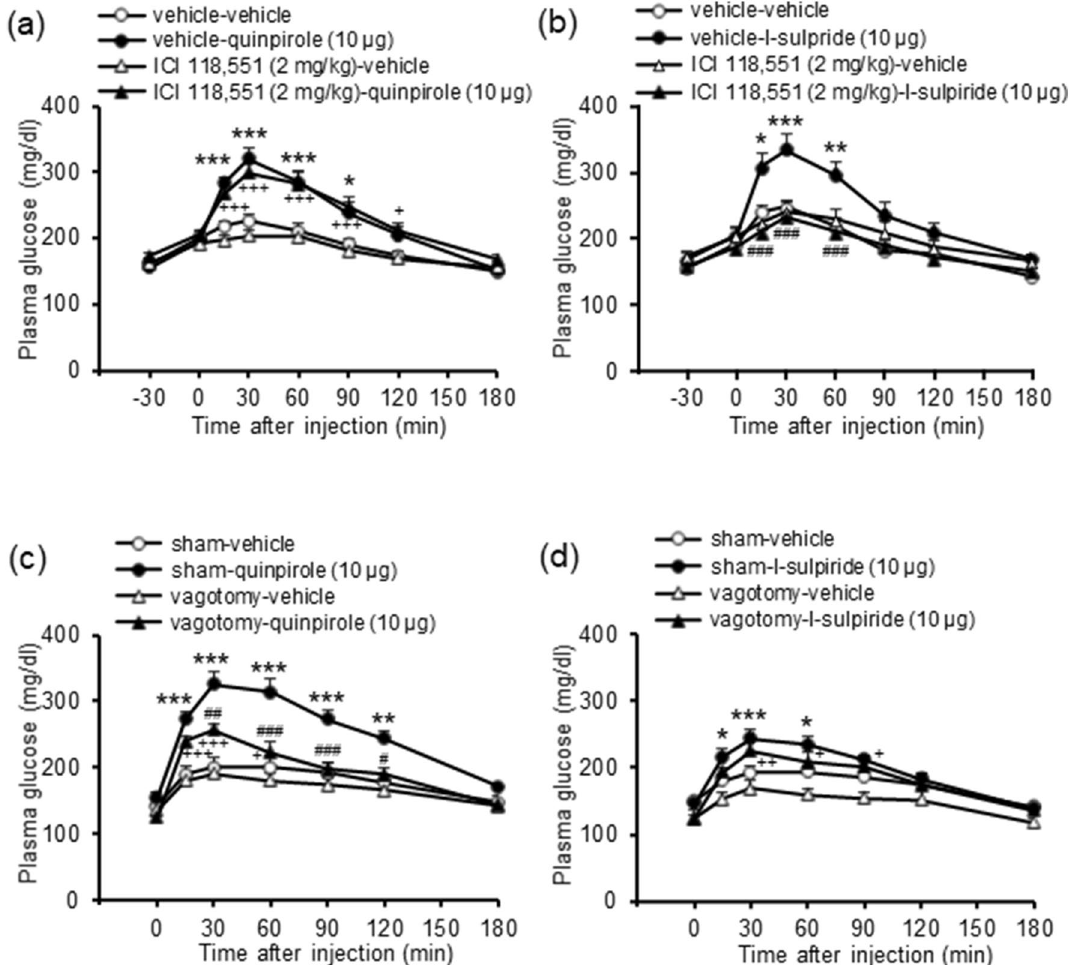
Figure 5. Role of sympathetic and parasympathetic nerves in hyperglycemia induced by the dopamine D 2 receptor agonist and antagonist. ( a , b ) Effect of the β 2 adrenoceptor antagonist ICI 118,551 on hyperglycemia induced by quinpirole or l-sulpiride. ICI 118,551 (2 mg/kg, i.p.) was administered 30 min before injection of quinpirole (10 μg, i.c.v.; a ) or l-sulpiride (10 μg, i.c.v.; b ). Each point represents the mean ± S.E.M. of 8–15 mice. * P < 0.05, ** P < 0.01, *** P < 0.001 vs. vehicle-vehicle group. + P < 0.05, +++ P < 0.001 vs. ICI 118,551-vehicle group. ### P < 0.001 vs. vehicle-l-sulpiride group. ( c , d ) Effect of hepatic vagotomy on hyperglycemia induced by quinpirole (10 μg, i.c.v.; c ) and l-sulpiride (10 μg, i.c.v.; d ). Hepatic vagotomy was conducted at least 1 week before drug injections. Each point represents the mean ± S.E.M. of 7–12 mice. * P < 0.05, ** P < 0.01, *** P < 0.001 vs. sham-vehicle group. + P < 0.05, ++ P < 0.01, +++ P < 0.001 vs. vagotomy-vehicle group. # P < 0.05, ## P < 0.01, ### P < 0.001 vs. sham-quinpirole